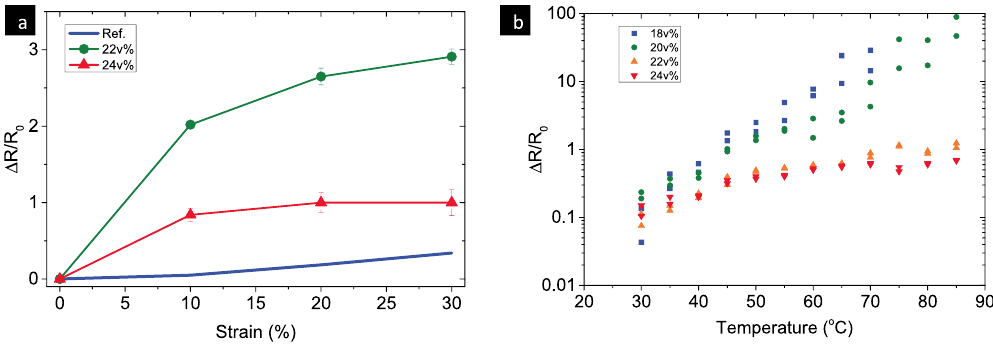
Figure 7. ( a ) A comparison of the change in resistance of Ag-PDMS with that of carbon nanotubes 24 ; and ( b ) Temperature effect on the electrical properties change of Ag-PDMS